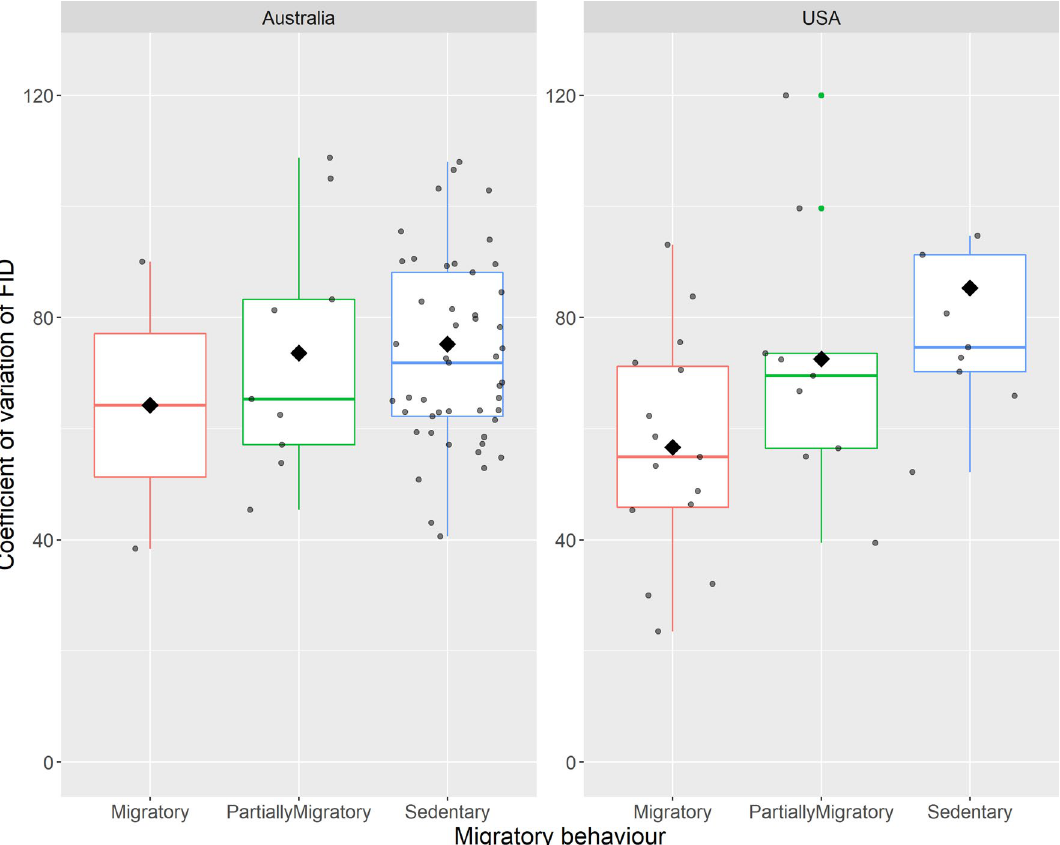
Figure 2. Difference in plasticity of escape behaviour (coefficient of variation of FID) migratory, partially migratory and sedentary birds, split by country where data were collected. The box plots show medians (horizontal bar), quartiles, 5- and 95-percentiles, jittered points (small-grey dots) and extreme values (small- coloured dots). Mean values are indicated with black rhombus.